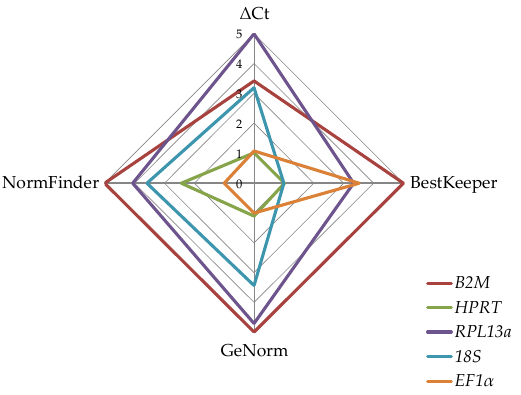
Figure 2. Inter-individual stability of the housekeeper genes. Five different housekeeping genes ( B2M , HPRT , RPL13 , 18S , and EF1 α ) were tested with cDNA from 10 different donors. The stability of the housekeeper genes was analyzed by ∆ Ct, BestKeeper, GENorm, and NormFinder methods. The results are presented as spider-web diagram with the stability values as axis. In summary, the housekeeping genes with the best inter ‐ individual stability were RPL13 and EF1 α .